Question: What does this figure show? Answer in one sentence.
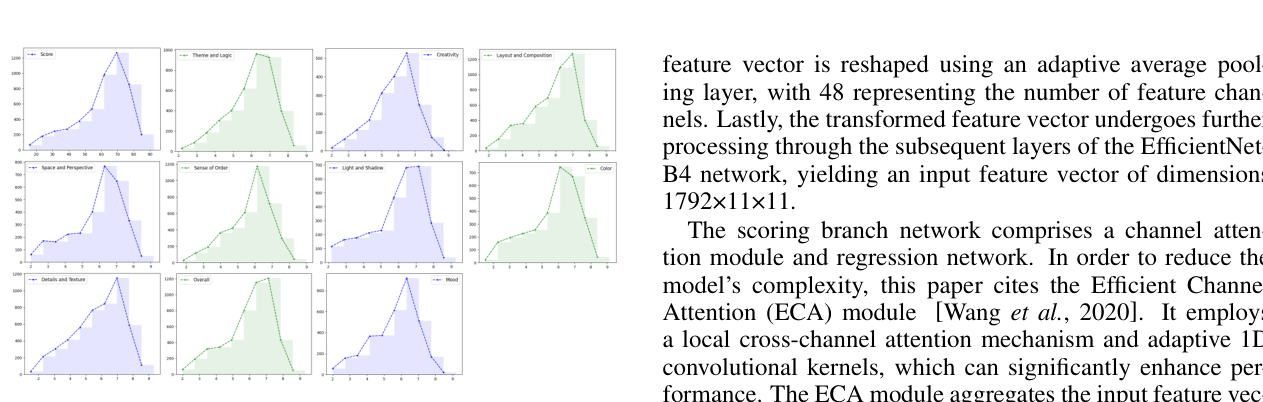
Answer: The score distribution of APDD. This distribution suggests a consensus on the aesthetic appeal of images, with most perceived as having a moderate level of appeal, while extreme scores are less frequent.